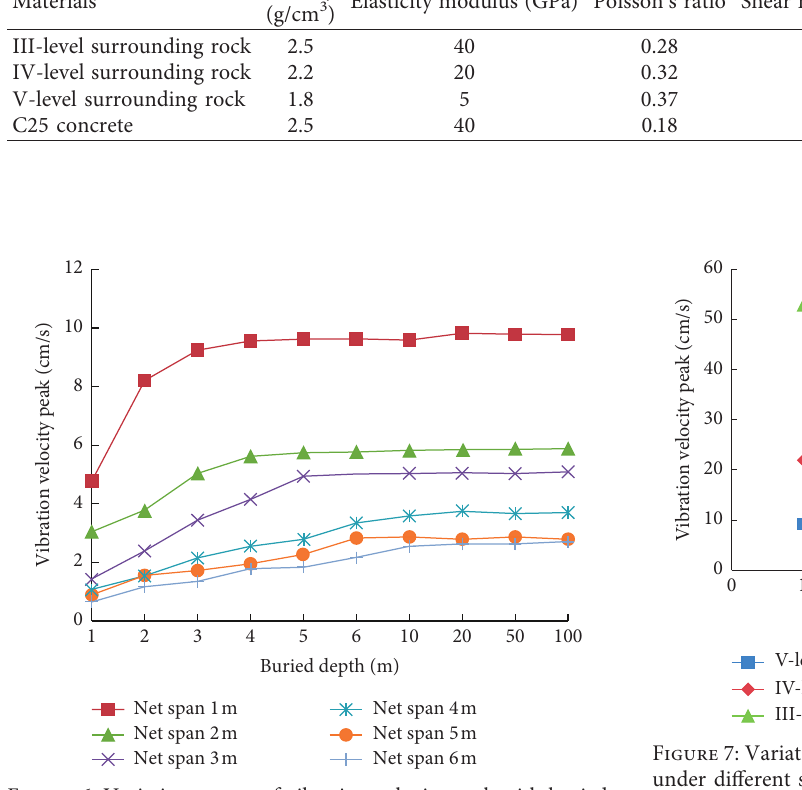
Figure 6: Variation curves of vibration velocity peak with buried depth at different net spans.